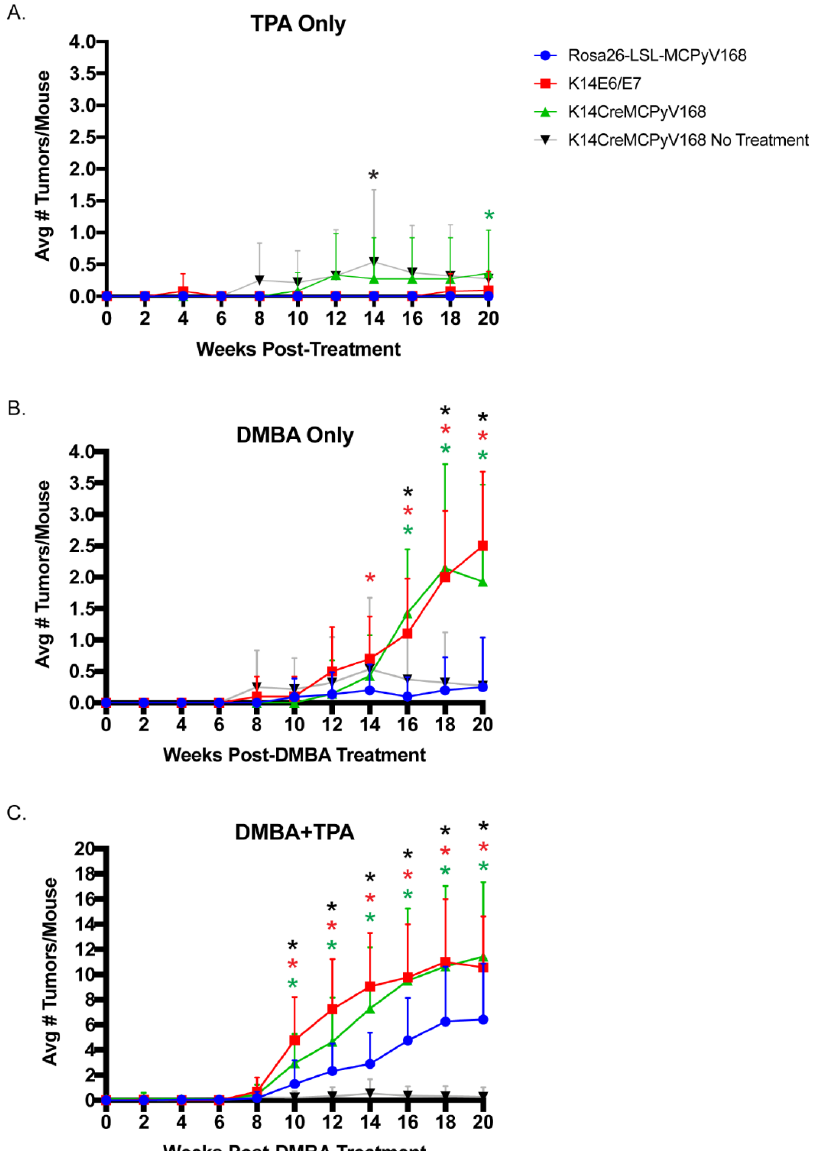
Figure 2. The MCPyV T antigens function as tumor promoters, not initiators, in murine skin and synergize with chemical carcinogens to exacerbate skin tumorigenesis. Groups of Rosa26-LSL-MCPyV168 (blue data points), K14E6/E7 (red data points), and K14Cre-MCPyV168 (green data points) mice were treated topically with ( A ) 15 nmol of TPA twice a week for 20 weeks, ( B ) one time with 0.3 µ mol DMBA, or ( C ) treated one time with 0.01 µ mol DMBA and then twice a week for 20 weeks with 15 nmol TPA. Tumor incidence over time in an untreated group of K14Cre-MCPyV168 mice is also included (black data points). At each time point, the average number of tumors/mouse in each group was calculated by dividing the total number of tumors by the total number of mice in each group. Group sizes were adjusted when necessary. A two-sided Wilcoxon rank-sum test was performed on data from each time point to compare the average number of tumors per mouse. Statistical significance is indicated with an asterisk for the comparisons indicated in the figure. Statistical significance indicated in ( A ) black asterisk: K14Cre-MCPyV168 No Treatment vs. Rosa26-LSL-MCPyV168 p = 0.05; green asterisk: K14Cre-MCPyV168 vs. Rosa26-LSL-MCPyV16 p = 0.05; ( B ) black asterisk: K14Cre-MCPyV168 No Treatment vs. K14Cre-MCPyV168 Treated p < 0.0004; red asterisk: K14E6/E7 vs. Rosa26-LSL-MCPyV168 p < 0.03; green asterisk: K14Cre-MCPyV168 vs. Rosa26-LSL-MCPyV168 p < 2 × 10 − 5 ; ( C ) black asterisk: K14Cre-MCPyV168 No Treatment vs. K14Cre-MCPyV168 Treated p < 1.6x10 − 9 ; red asterisk: K14E6/E7 vs. Rosa26-LSL-MCPyV168 p < 0.008; green asterisk: K14Cre-MCPyV168 vs. Rosa26-LSL-MCPyV168 p < 0.04. The number of mice per group is indicated in Table 1. Error bars indicate standard